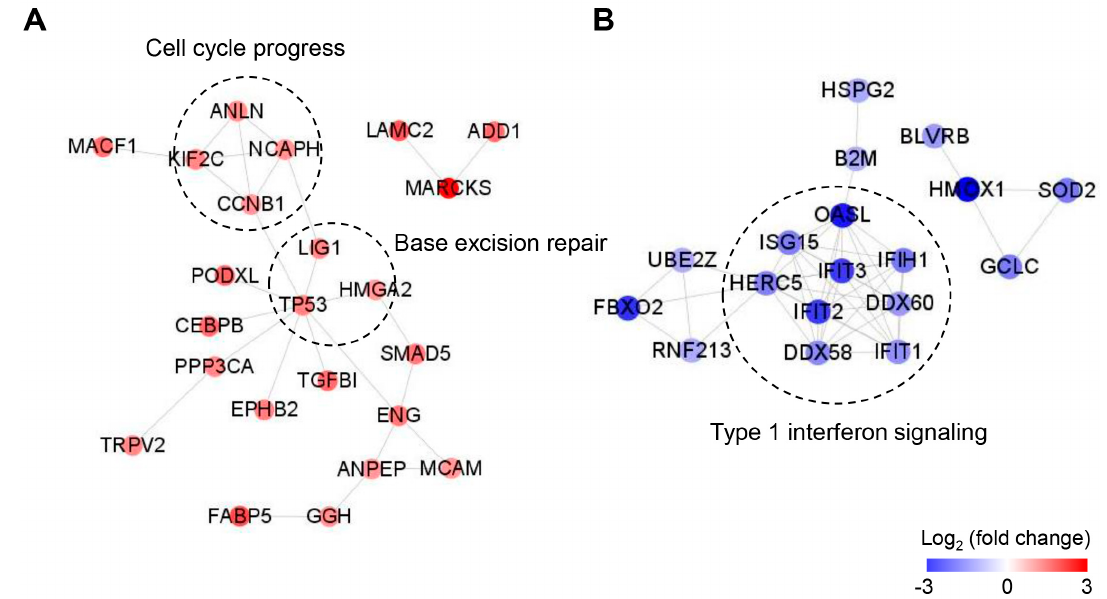
Figure 4. Protein–protein interaction (PPI) network analysis of up ( A ) and down ( B ) regulated proteins in oxaliplatin- resistant PANC-1 cells. The network was mapped using the STRING database and visualized by Cytoscape 3.7.2. Red nodes indicate up-regulation and blue nodes indicate down-regulation.